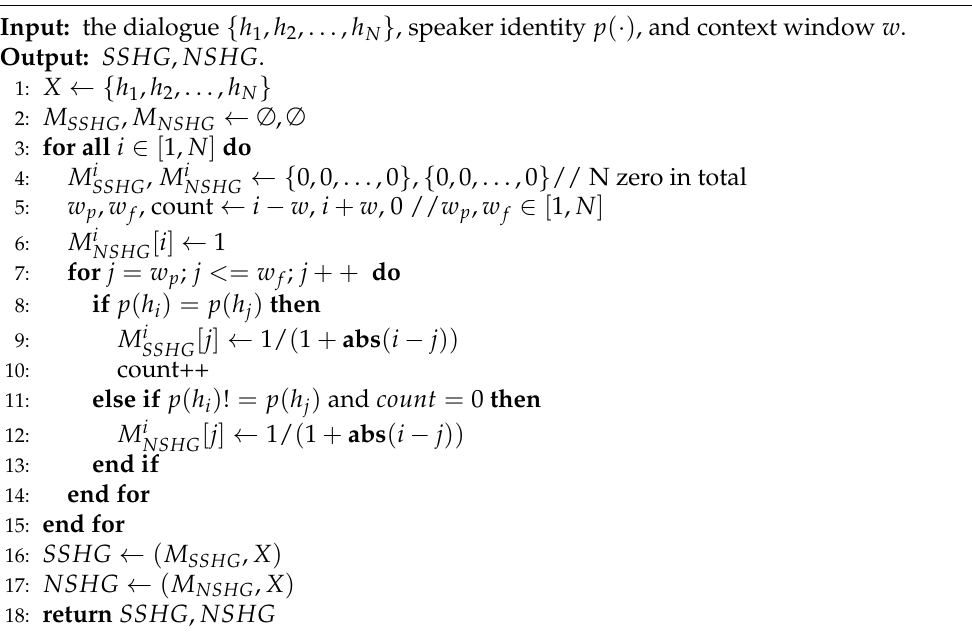
Algorithm 1 Constructing a